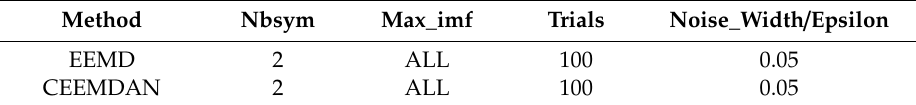
Table 2. Parameters